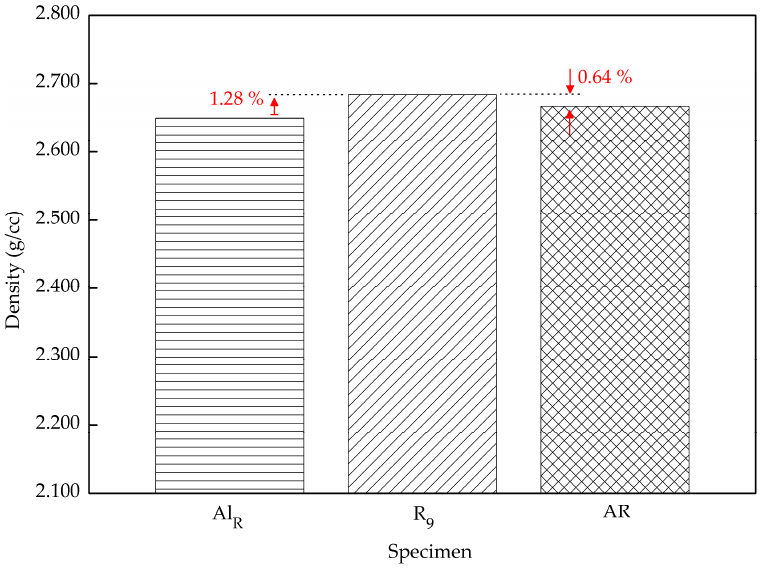
Figure 8. Residuals for density between the maximum (R 9 ) parameter settings compared to the Al R and AR AA6061 samples.